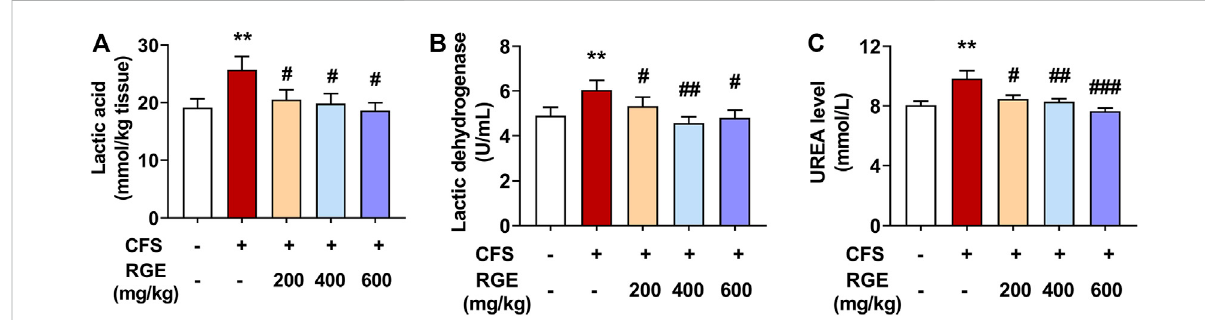
FIGURE 2 The effects of RGE on lactic acid, lactic dehydration and urea in chronic fatigue syndrome mice. (A) . Lactic acid content in tibialis anterior (TA) musclesoftheindicatedgroups. (B,C) .Lacticdehydrationandureainserumoftheindicatedgroups.Micefromcontrolorchronicfatiguesyndrome model group were treated with water or different dose of RGE (200, 400 or 600 mg/kg). n = 6 mice per group. Compared with control group, ** p < 0.01; compared with CFS group, # p < 0.05, ## p < 0.01, ### p < 0.001.